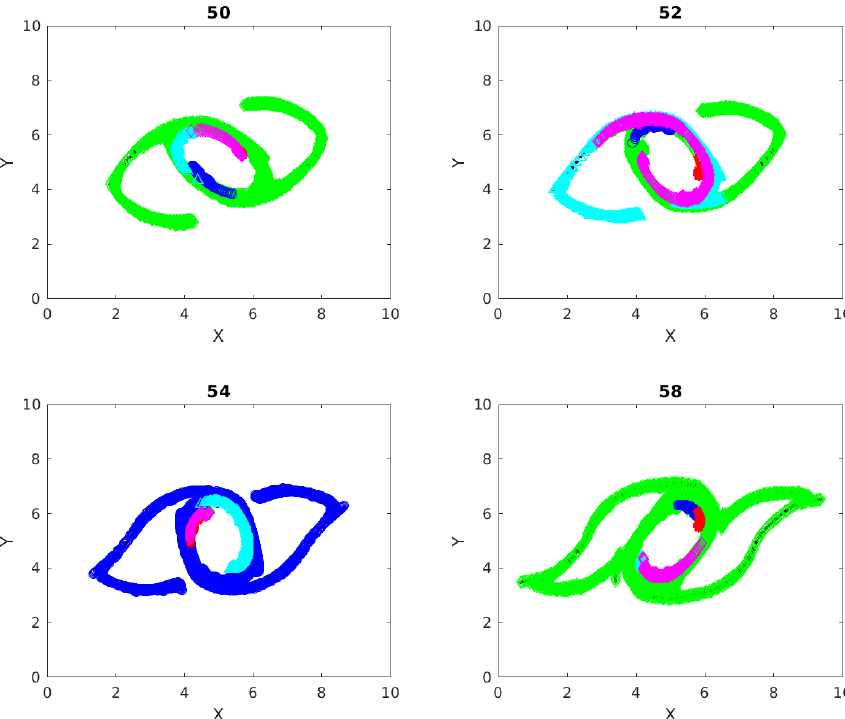
Figure 15. Spectral clusters found at multiple times from within cluster